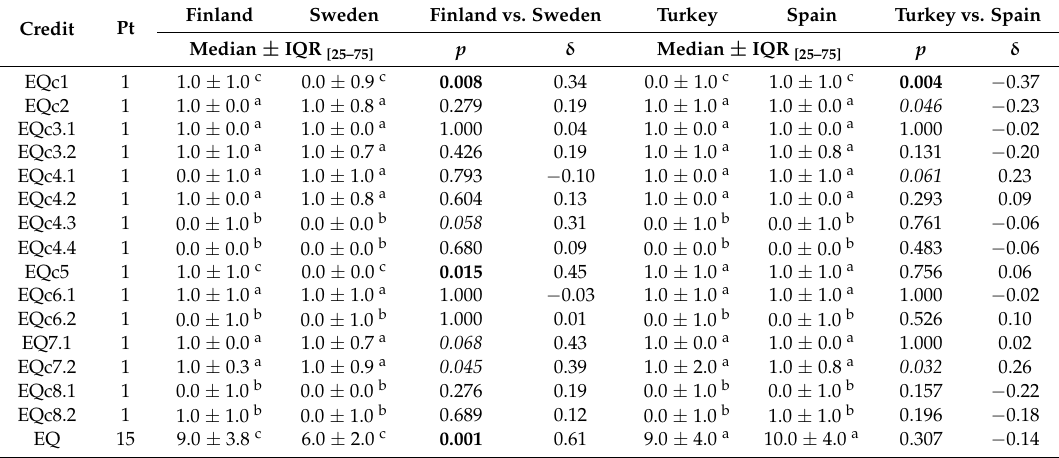
Table 7. EQ achievement: Northern European countries vs. southern European